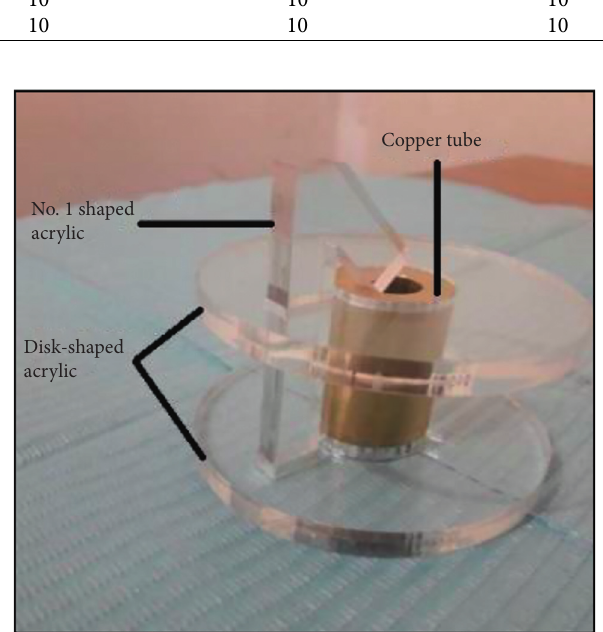
Figure 1: Acrylic patterns (disk-shaped and no. 1 shaped trans- parent acrylic) and copper tube